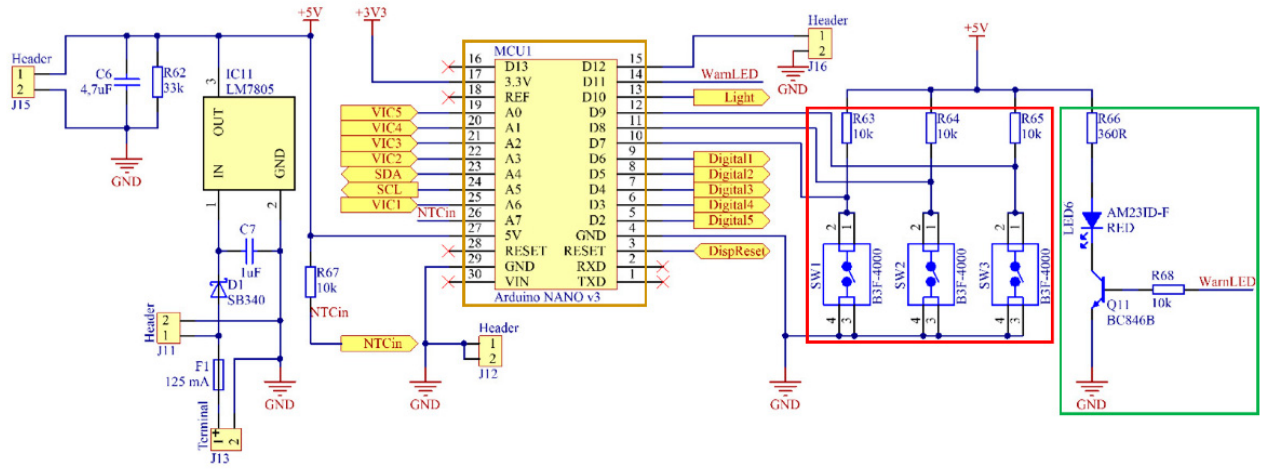
Figure 3. “Microcontroller” schematic sheet.